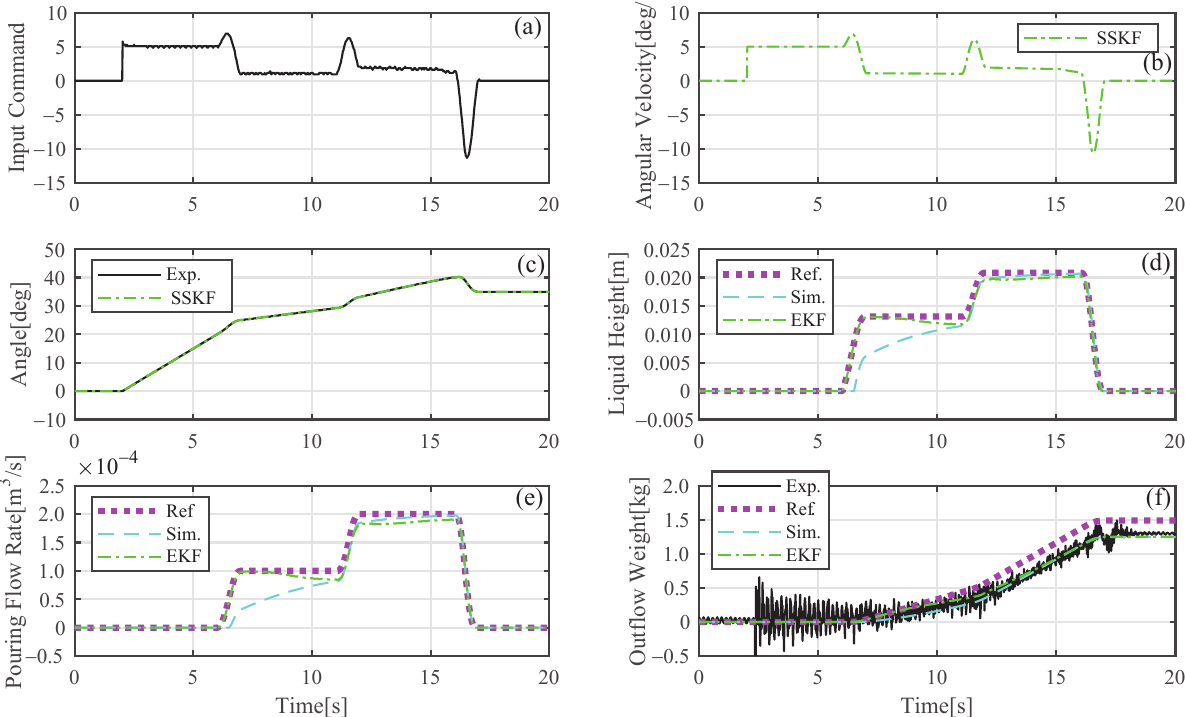
Figure 19. Experimental results using automatic pouring machine (tilting angle error at the start of liquid outflow: + 3 deg). ( a ) Input command to motor for tilting ladle; ( b ) Angular velocity of tilting ladle; ( c ) Angle of tilting ladle; ( d ) Liquid height on pouring mouth; ( e ) Flow rate of outflow liquid from ladle; ( f ) Weight of outflow liquid from